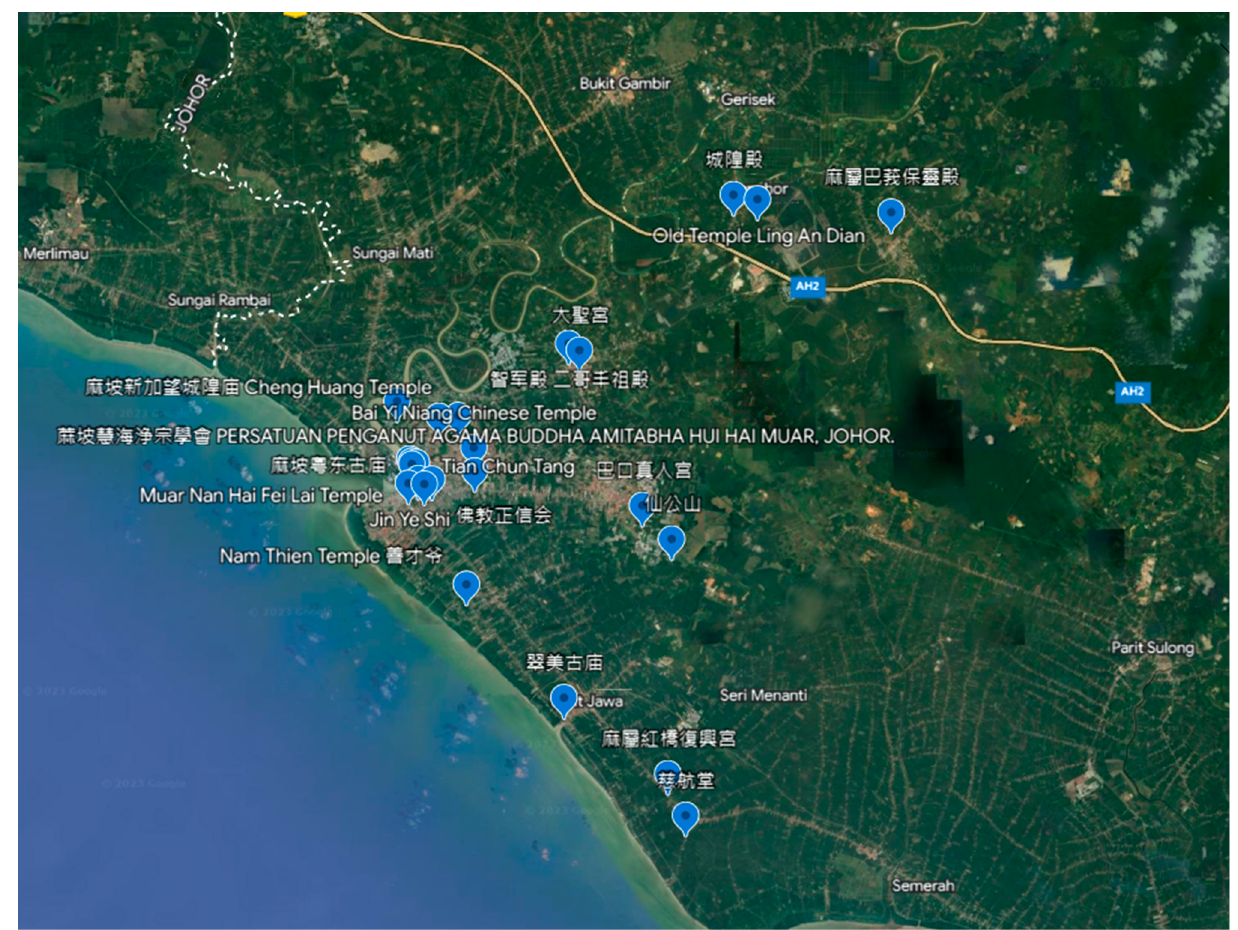
Figure 5. Muar Temples Distribution Map in 1850–2020. Table 8. Temple Establishment Year on Each